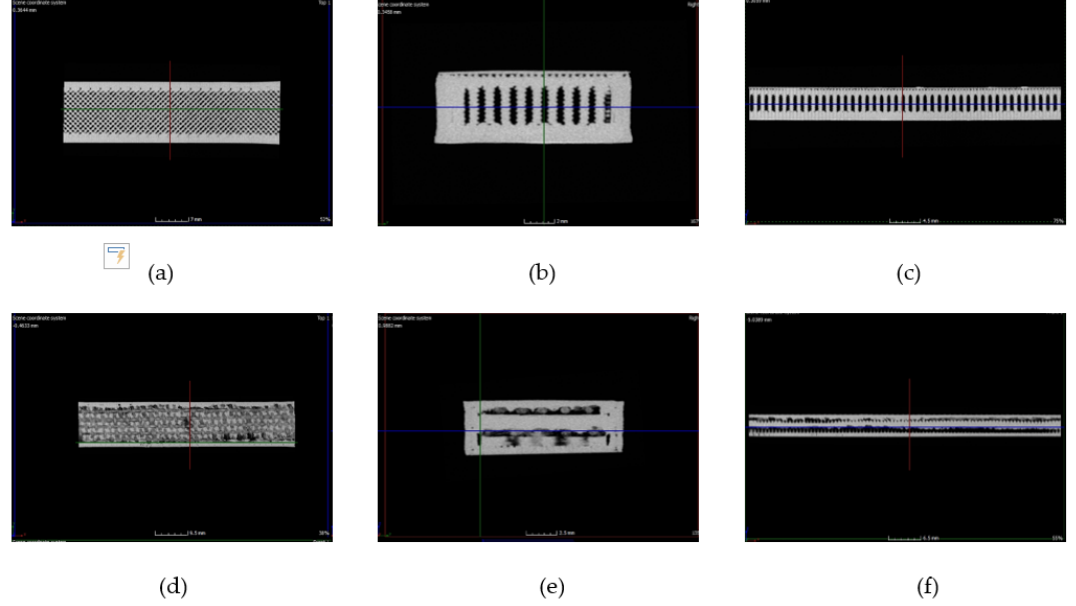
Figure 3. Tomography scans corresponding to PLA (upper) and PLA composite (bottom): ( a ) front view, ( b ) top view, ( c ) lateral view, ( d ) front view, ( e ) top view, ( f ) lateral view. Because of densities, PLA looks white, jute fiber appears grey, and the air is black. The inspection was performed in the gage zone of the tensile specimens before the test (Figure